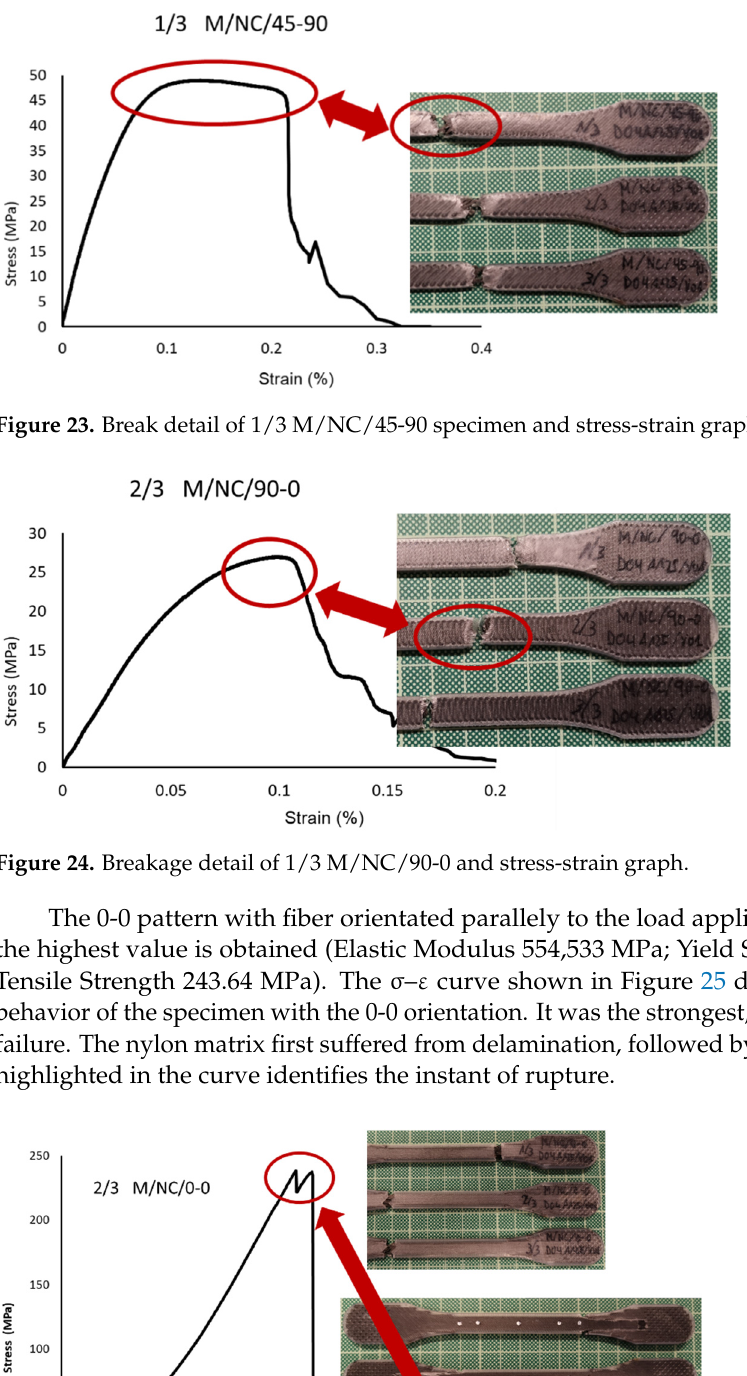
Figure 22. Nylon + CarbonFiber M/NC/45-45, M/NC/0-0, M/NC/45-90, and M/NC/45-90 specimens and Stress-Strain graphs.